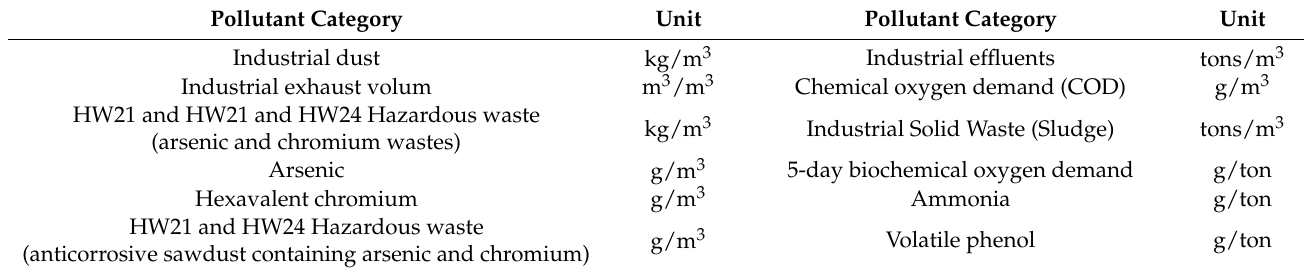
Table A2. Description of pollutant measurement